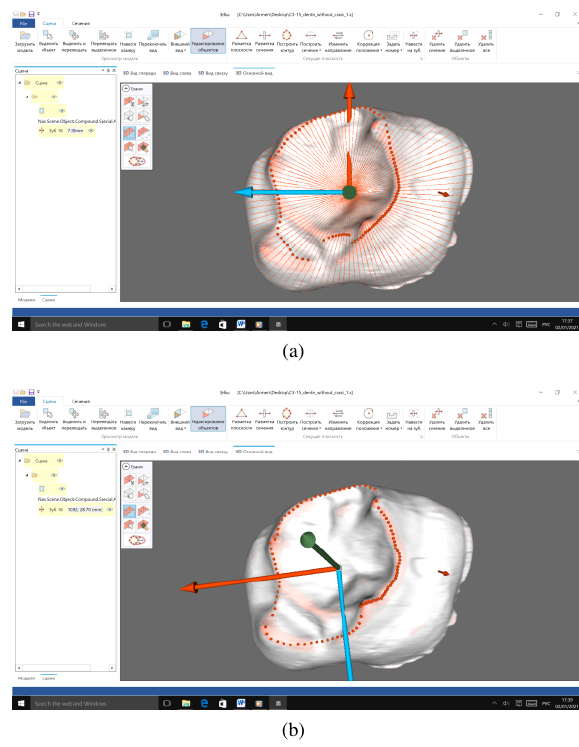
Figure 2. Orientation algorithms before (a) and after (b) manual adjustments.